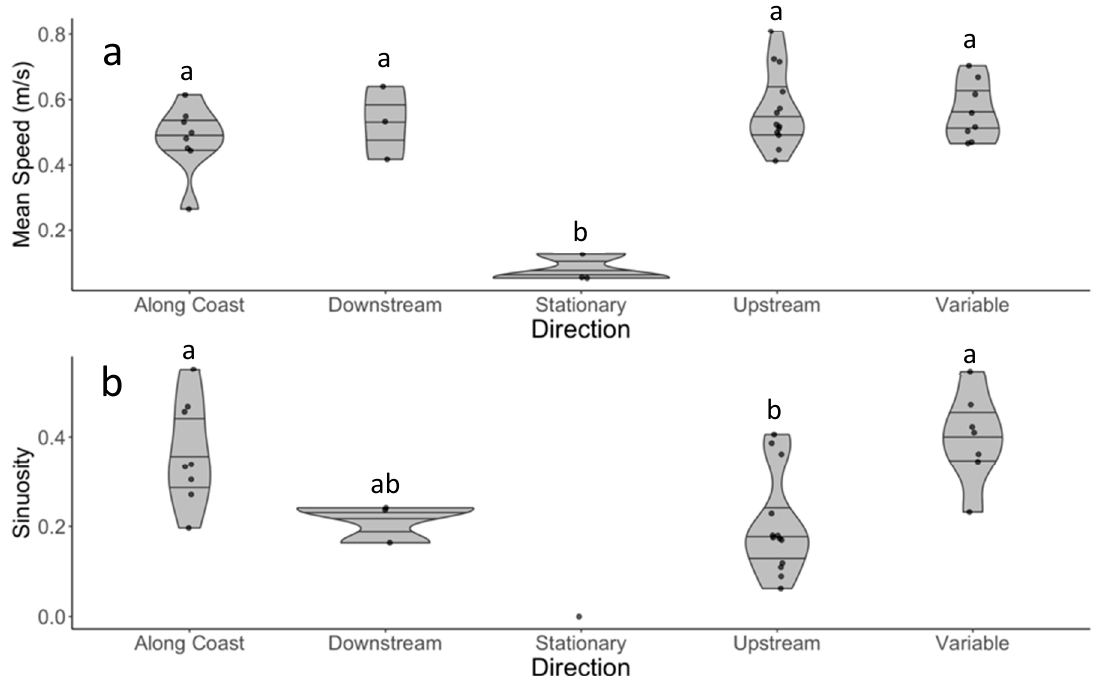
Figure 13. ( a ) The relationship between mean speed and direction. Dots represent individual tracks. The lines represent the quantiles. The letters represent the Tukey test results indicating differences between groups. ( b ) The relationship between sinuosity and direction. Stationary tracks were removed from this analysis due to the inability for the drone to maintain an entirely stable position in the air while observing a stationary ray, resulting in highly sinuous track metrics despite no movement of the animal. Dots represent individual tracks. The lines represent the quantiles. The letters represent the Tukey test results indicating differences between groups.